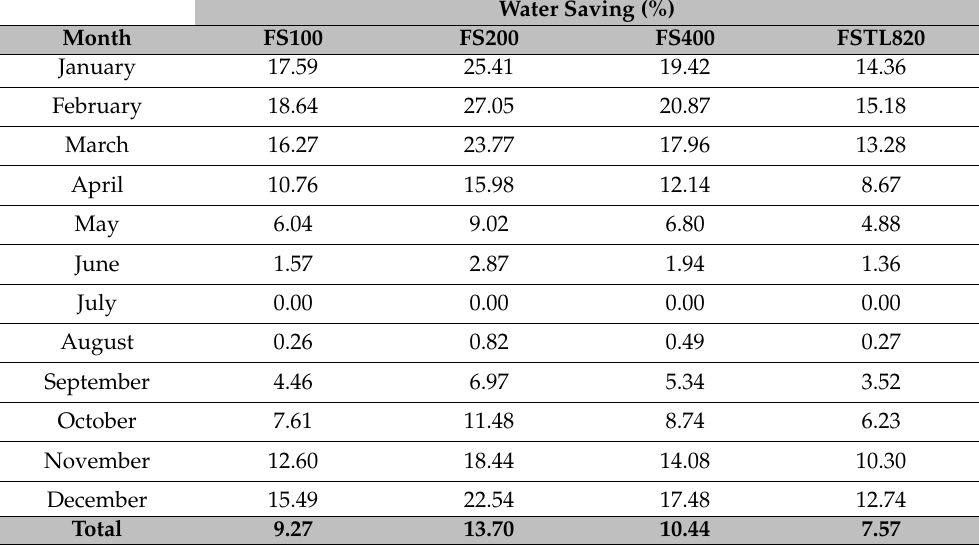
Table 11. Backwash water savings of 8 GAC filters with monthly adjustment of backwash intensity versus backwash at constant intensity throughout the year in